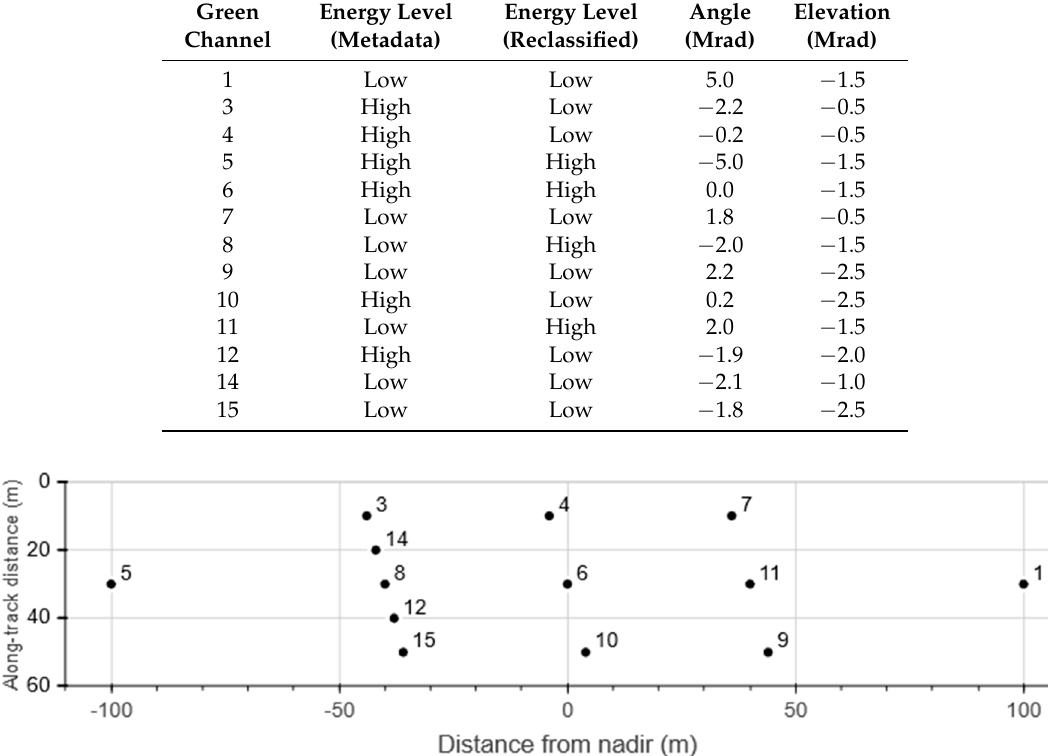
Figure 3. Thirteen green channels were configured for the MABEL “Transit to KPMD” mission. The graph shows the across- and along-track distances for each channel, given a nominal operational height above ground level (AGL) of 20,000 m.